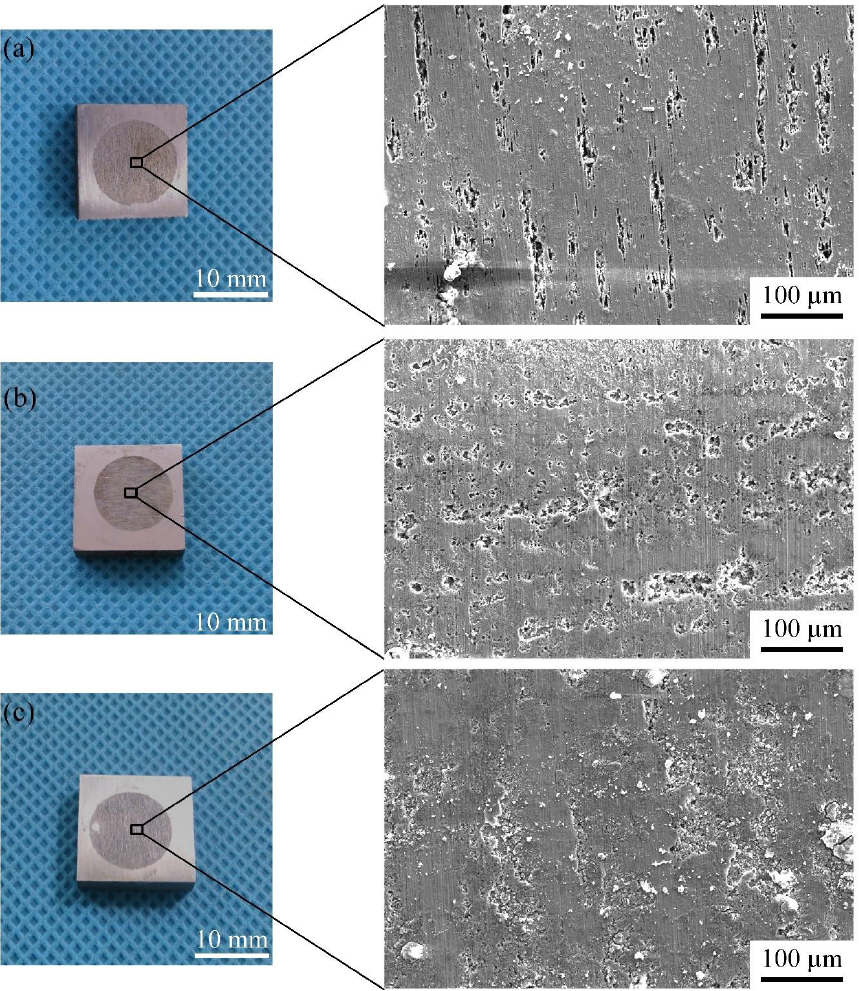
Figure 10. Macro morphology and the corresponding SEM images of the sample with different heat treatment conditions after dynamic potential polarization test. ( a ) Base metal; ( b ) 300 °C and ( c ) 350